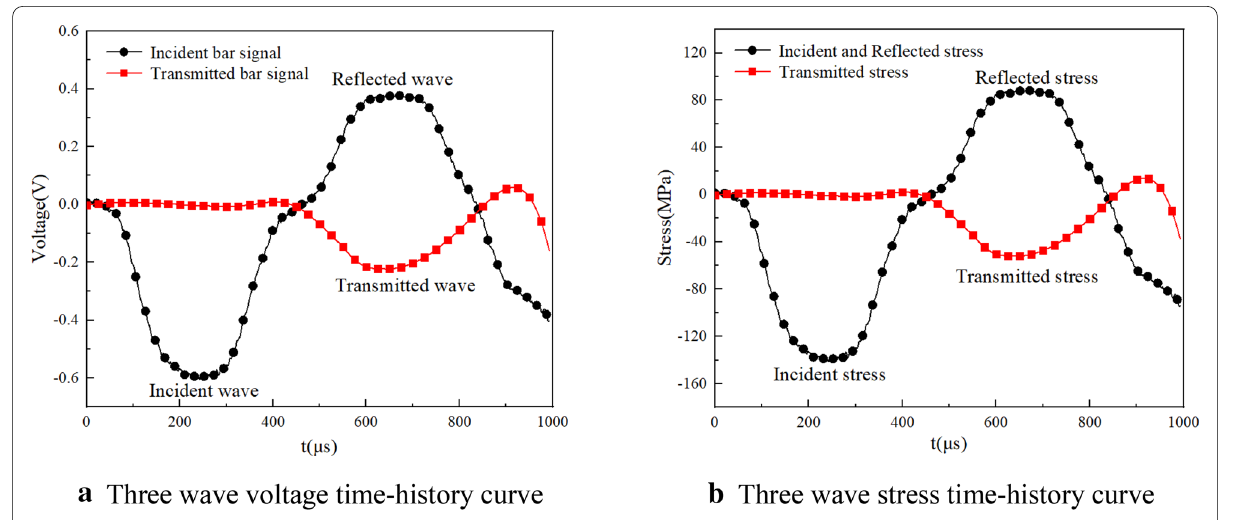
Fig. 14 Time-history curve.